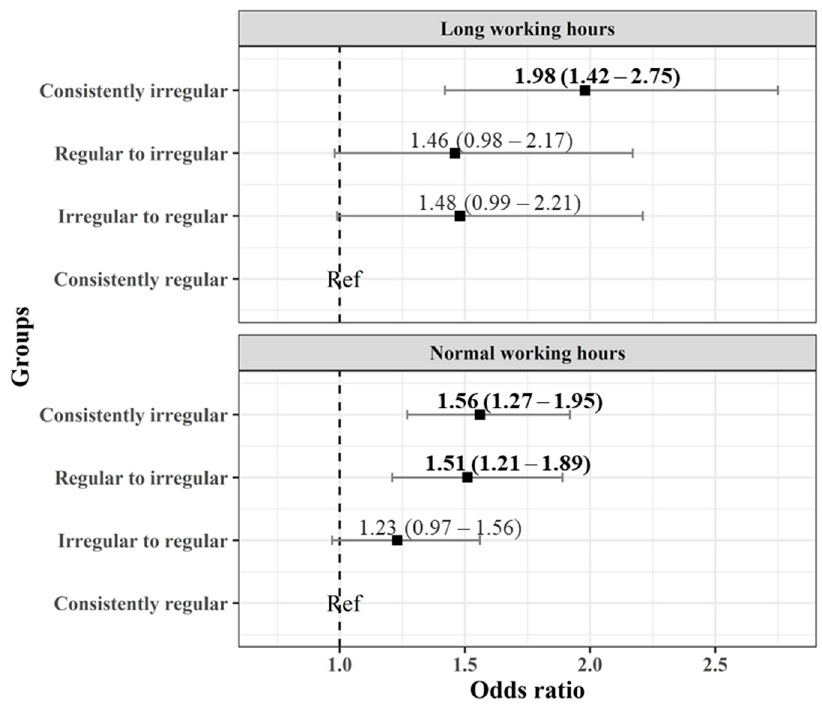
Figure 2. Odds ratio of cognitive impairment according to changes in the regularity of working hours with long and normal working hours (“consistently regular” group being a reference).